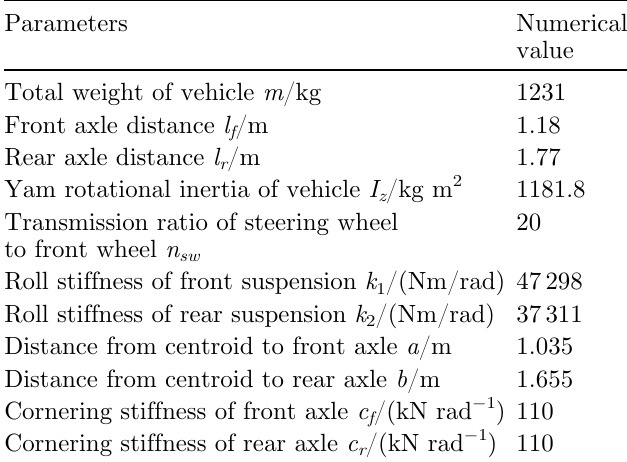
Table 1. Vehicle parameters.